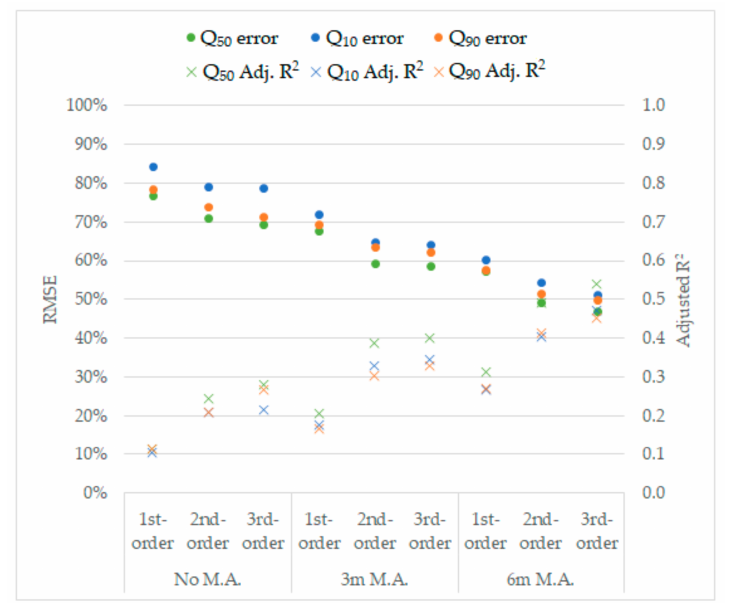
Figure 3. The root mean square error (RMSE) and adjusted R 2 of the multiple regression (MR) models. The 1st-, 2nd-, and 3rd-order are the respective MR orders. The 3 m M.A. and 6 m M.A. are the 3-month and 6-month moving average,